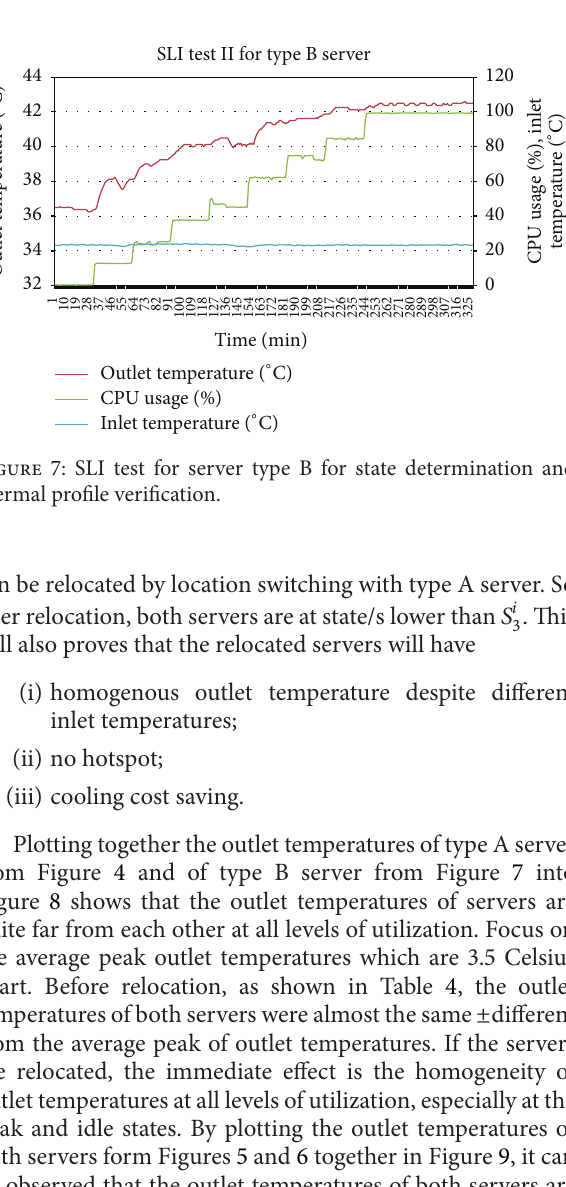
Figure 6: SLI test for server type A for state determination and thermal profile verification.